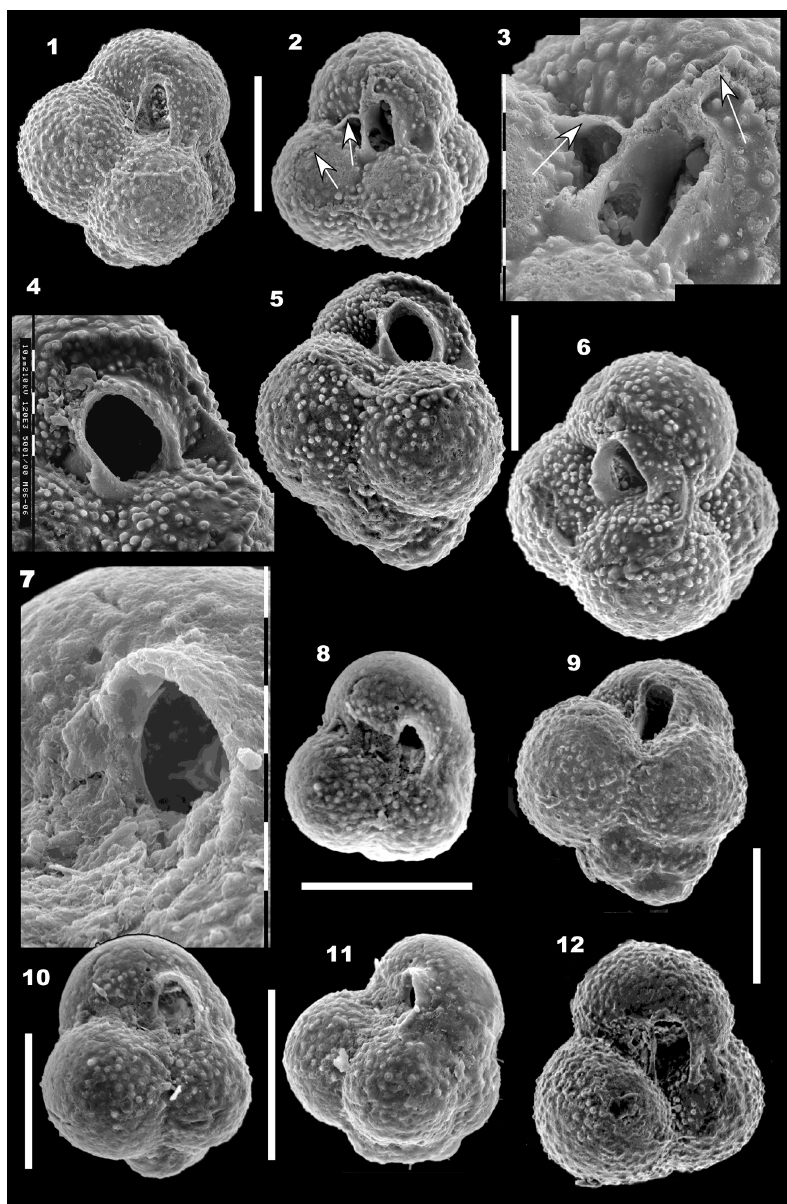
Figure 4. (1–12) Globuligerina altissapertura n. sp. 1, Paratype WAM 18.7/M10-22, oblique umbilical view. Note the scar of a terminal bulla, now broken off. Scale bar for (1) and (2) : 100µm. (2–3) Paratype WAM 18.5/M73-14; (2) umbilical view to show the narrow, high- arched aperture. The terminal bulla is broken off but visible as broken walls and a scar on the last three chambers (arrowed). (3) Detail of the aperture and a small section of the thin-walled broken bulla (arrowed). Composite photomosaic, each division of scale at left is 10µm. (4–6) Paratype WAM 18.6/M86-6 from sample BMR 96/DR28/16. (4) Detail of the aperture, showing the high tilted arch, prominent lip and the outwards turning of the lip to form a small hook-like plate on the umbilical side of the aperture. Each small scale bar is 10µm. (5) Side view; a final bulla is broken off. (6) Oblique umbilical view, showing the very prominent lip around the aperture in partial side view. The scale bar between (5) and (6) is 100µm. (7, 8, 10–11) Paratype WAM 18.4/M55-27. (7) Detail of the aperture; apertural lip is broken on the umbilical side. Each division of scale bar: 10µm. (8) Umbilical view, showing the narrow high tilted aperture and the three chambers in the final whorl, plus the faint scar of a possible broken-off bulla covering the umbilical surface. Scale bar below (8) : 100µm. (10) Oblique umbilical view, tilted away from viewer relative to (8) to show apertural shape. (11) Side view, rotated to show the prominence of the projecting apertural lip on the final chamber. Note the almost flat initial whorl at the base; this is unusual. Scale bar for (10) and (11) : 100µm. (9, 12) Holotype WAM 18.3/M10-23. (9) Side view with proloculus clearly visible at the base and secondary lamination infilling the wall ornament on the early chambers. (12) Umbilical view. The high loop-shaped aperture is almost centrally located above the suture of the second-last and third-last chambers. Scale bar between (9) and (12) : 100µm. Specimens from sample BMR 95/DR7/8 unless stated